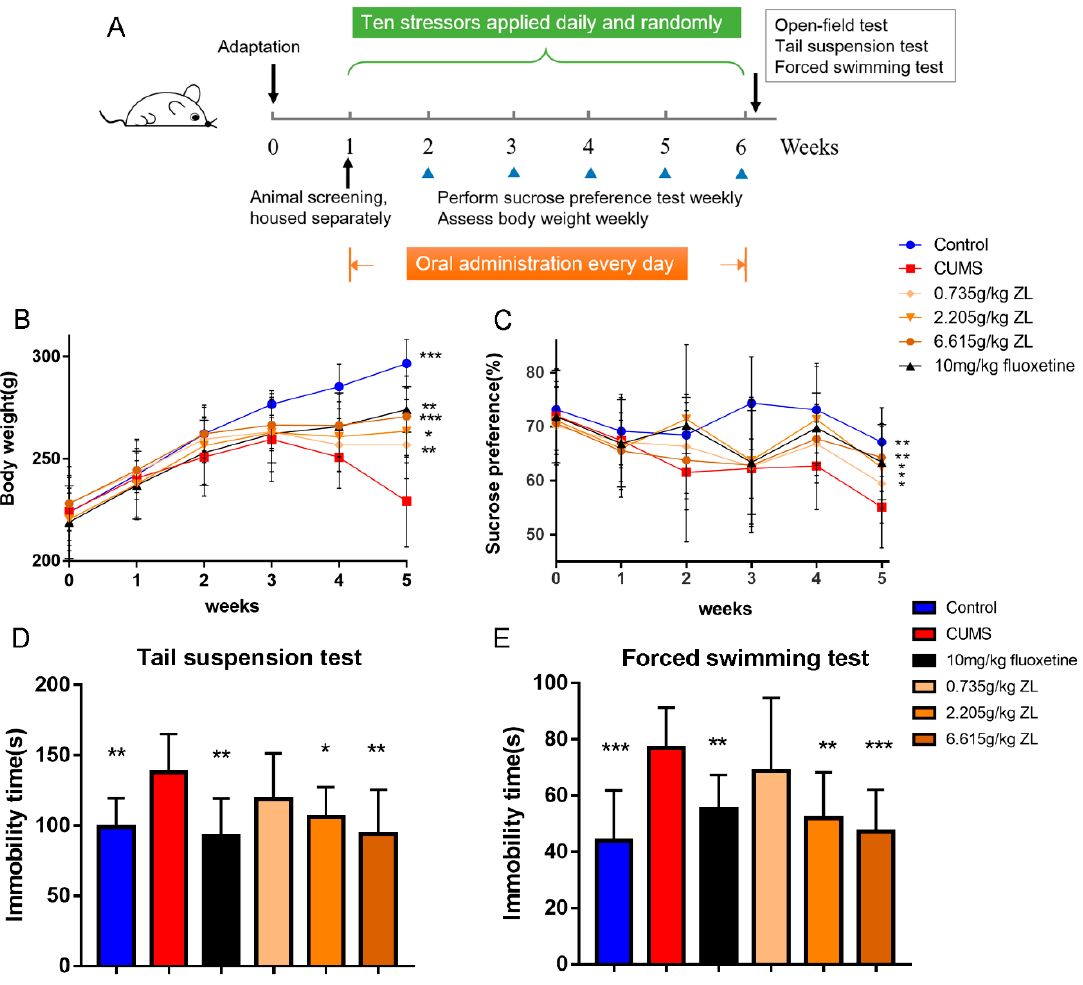
Figure 1. Effects of Zhile (ZL) on depressive-like behaviors of chronic unpredictable mild stress (CUMS) rats. CUMS procedure and experimental design ( A ). Effects of ZL on body weight ( B ), sucrose preference test (SPT) ( C ), tail suspension test (TST) ( D ), and forced swim test (FST) ( E ). All data are represented as mean ± standard deviation (SD). * p < 0.05, ** p < 0.01 and *** p < 0.001 versus CUMS group.